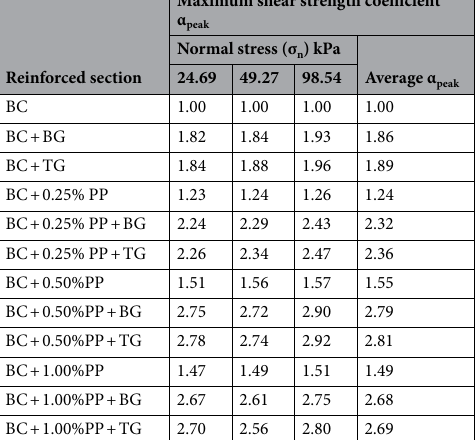
Table 6 summaries the measured maximum and average shear strength coefficients for normal stresses of 24.69 kPa, 49.27 kPa and 98.54 kPa. The average peak interface shear strength coefficients of the subgrades with